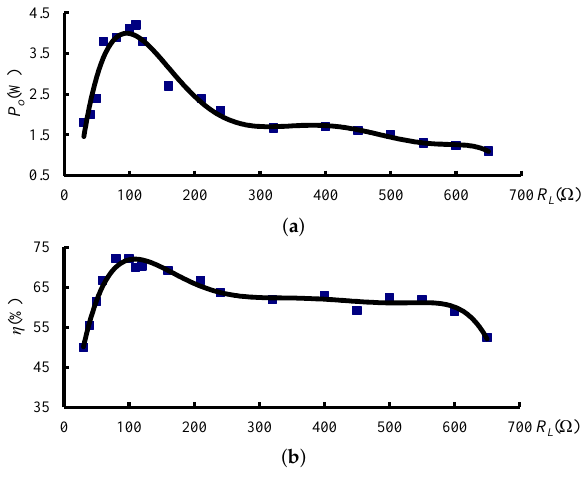
Figure 11. Power transfer and efficiency curves of ECPTC: ( a ) Output power versus the load; ( b ) System efficiency versus the